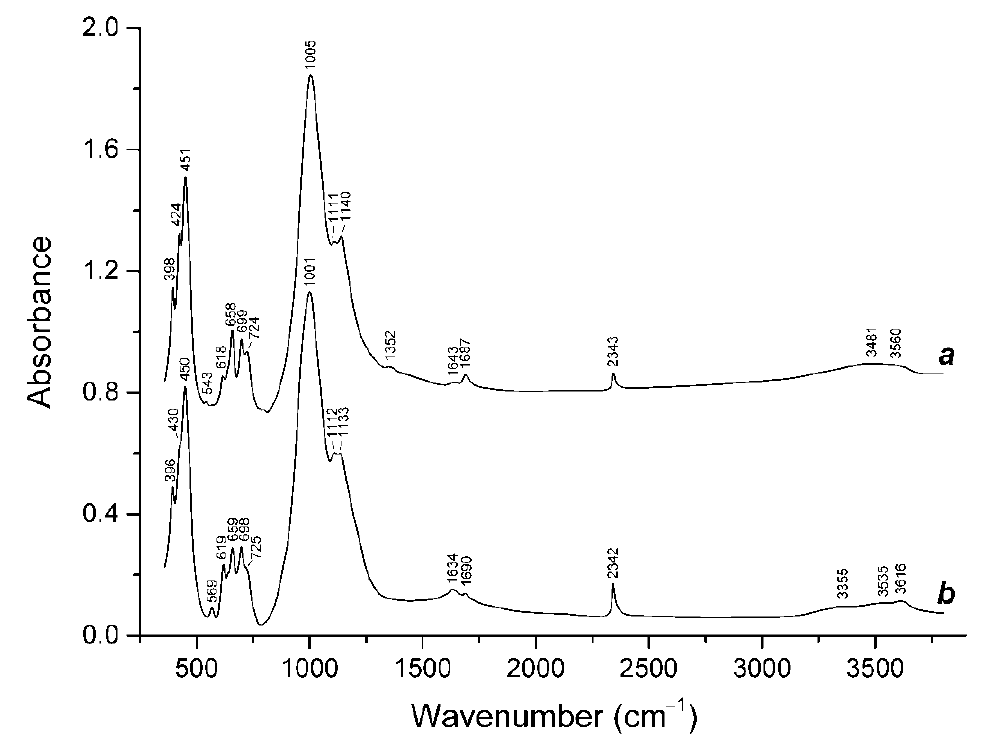
Figure 6. Infrared spectra of ( a ) nosean from the Eifel region (Sample 7) and ( b ) nosean from South Urals (Sample 8).